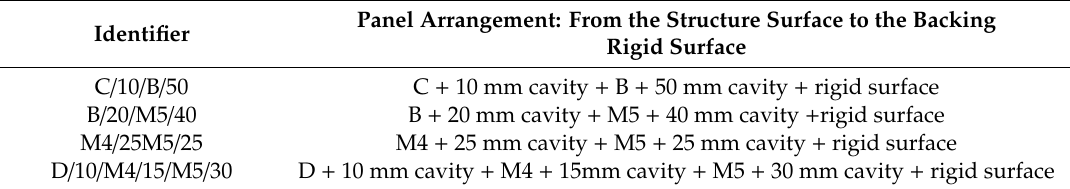
Table 2. Configurations of multi-leaf resonant absorbers used in the preliminary test. Panel Arrangement: From the Structure Surface to the Backing Identifier Rigid